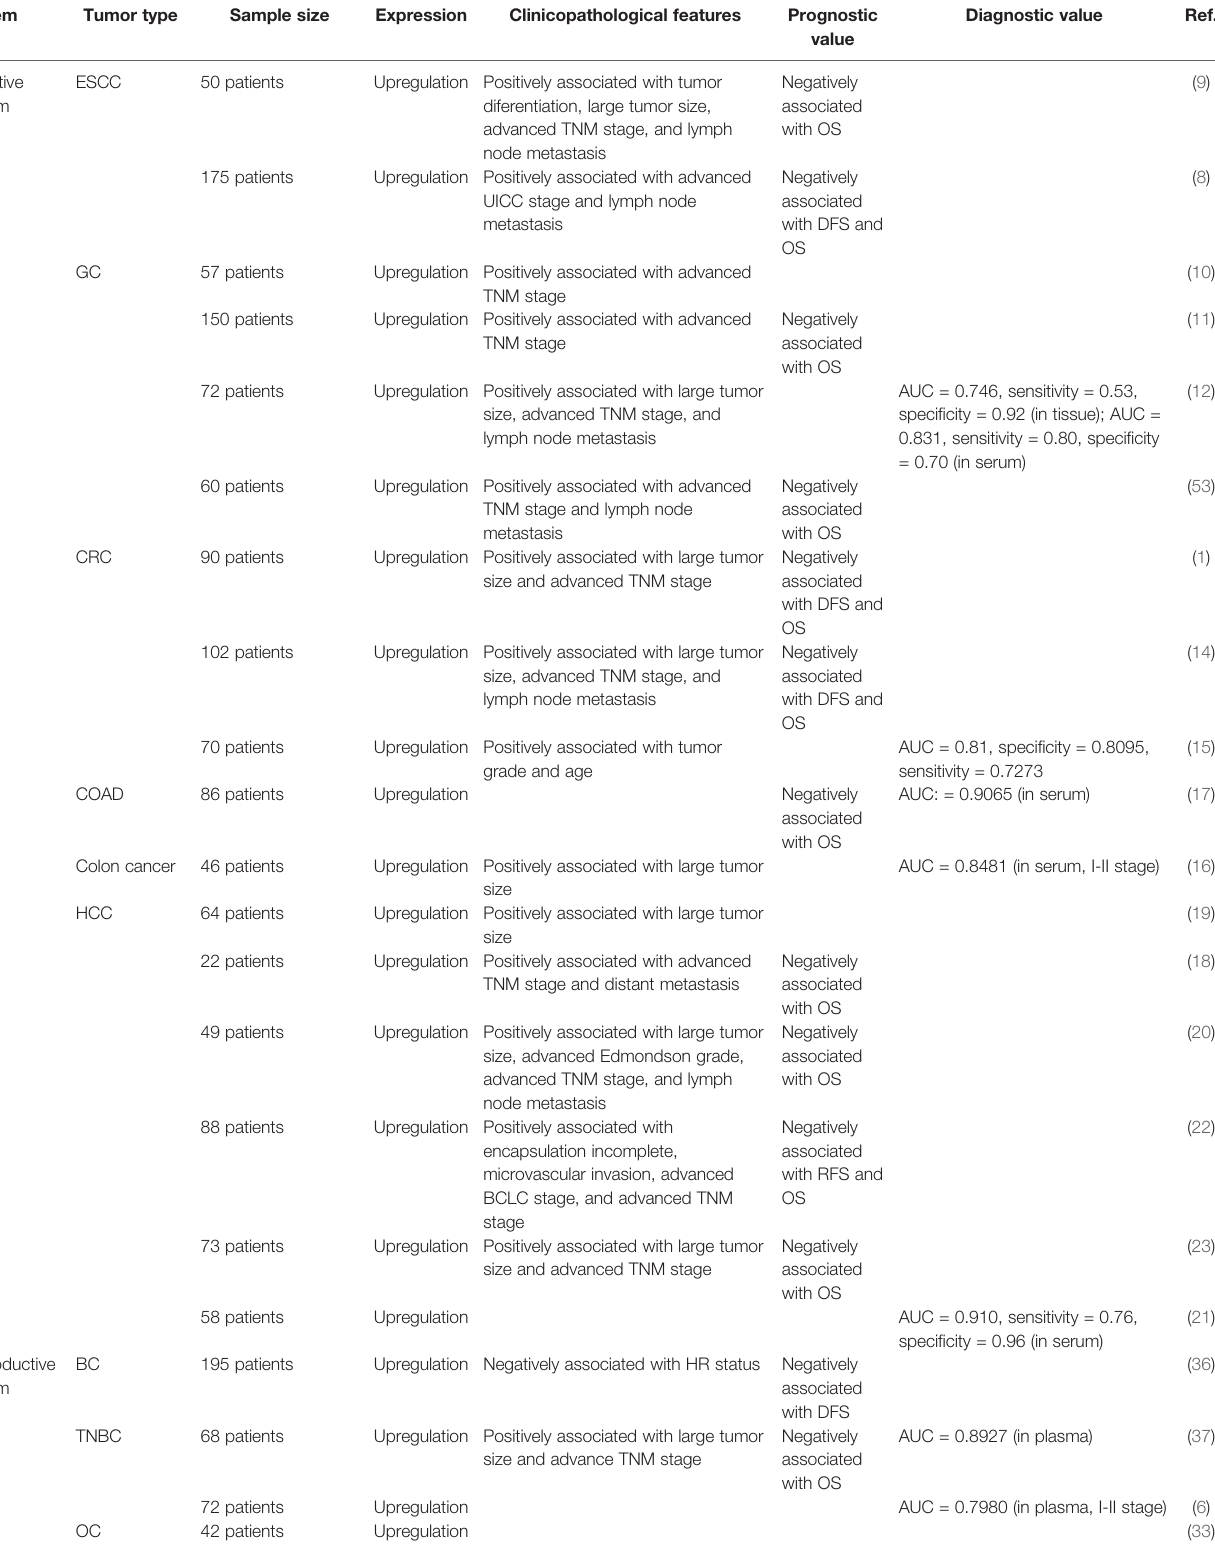
TABLE 2 | Clinicopathologic signi fi cance of MIR4435-2HG in human